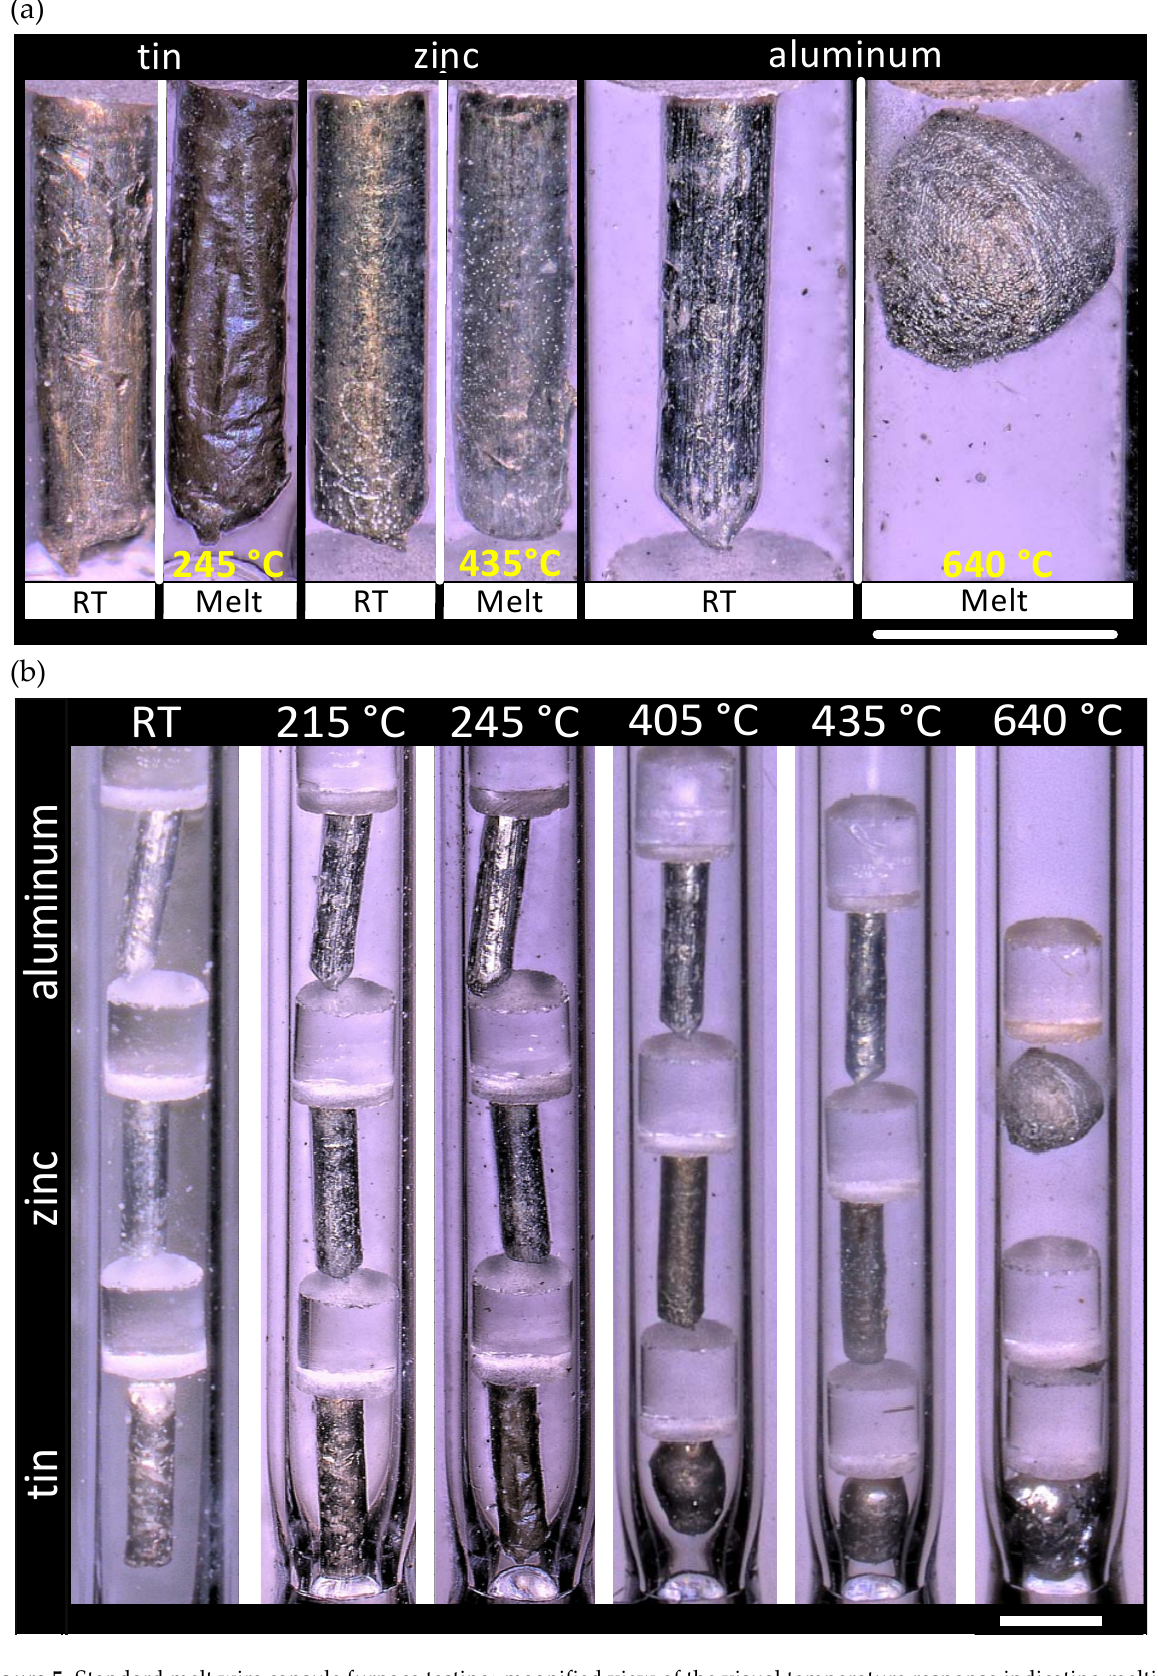
Figure 5. Standard melt wire capsule furnace testing: magnified view of the visual temperature response indicating melting of ( a ) individual melt wires of Sn, Zn and Al, and ( b ) of the full capsule. Scale bars represent 1 mm.